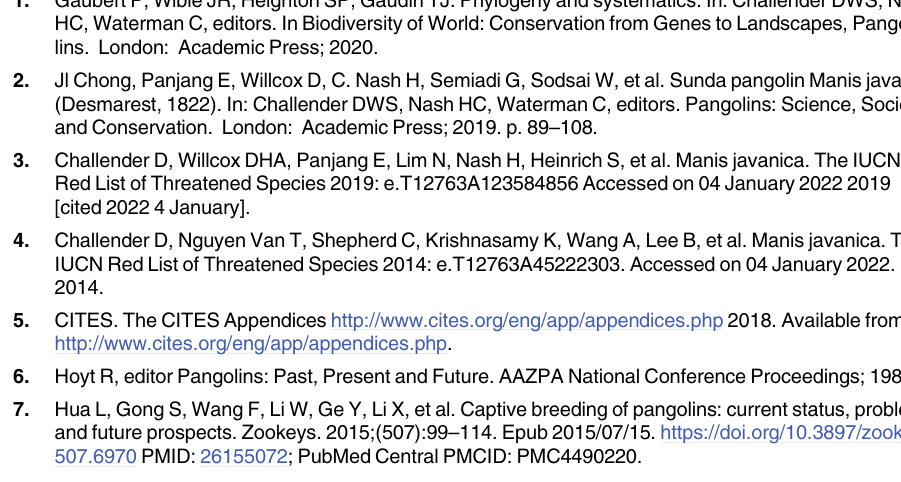
S2 Table. Fitted values of the feeding (n = 4) and non-feeding (n = 5) groups of Sunda pan- golins ( Manis javanica ) at different ages. S3 Table. The regression equation of the growth curve for each cub. S4 Table. Details regarding the length and mass of female Sunda pangolins ( Manis java- nica ) at